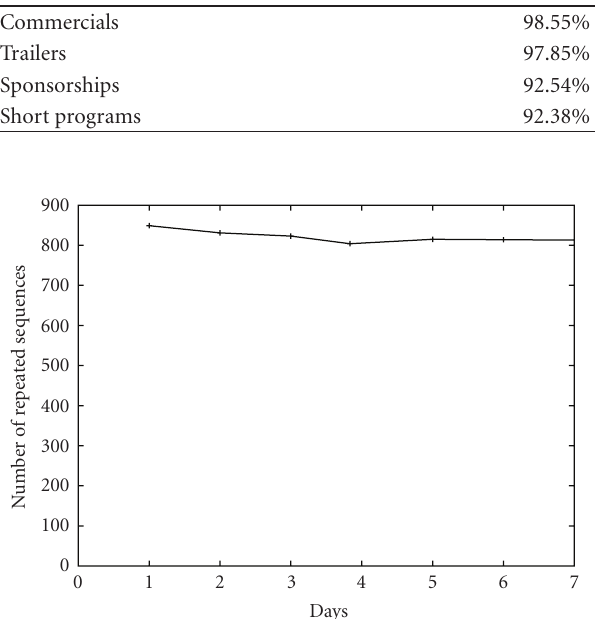
64.54%. In other words, about 35% of the detected repeated sequences are repeated segments that are parts of long programs.